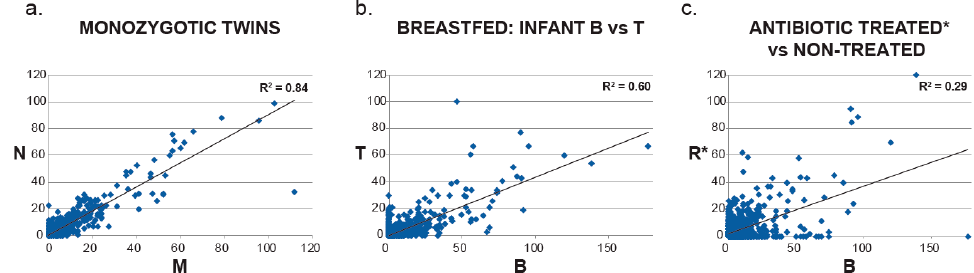
Figure 4. Pairwise correlations of protein metacluster spectral counts of individual infants comparing monozygotic twins ( a ), unrelated breastfed male infants ( b ) and antibiotic-treated vs non-treated infants ( c ). Pearson correlation coefficient values are provided for each comparison. * Antibiotic used was amoxicillin.